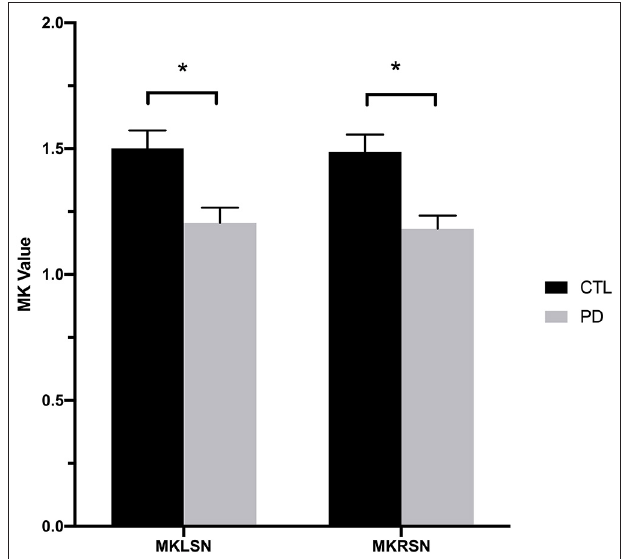
FIGURE 1 | Mean kurtosis values for the bilateral substantia nigra in the Parkinson’s disease and control groups. CTL, control; MKLSN, mean kurtosis of the left substantia nigra; MKRSN, mean kurtosis of the right substantia nigra; PD, Parkinson’s disease. * p < 0.05.